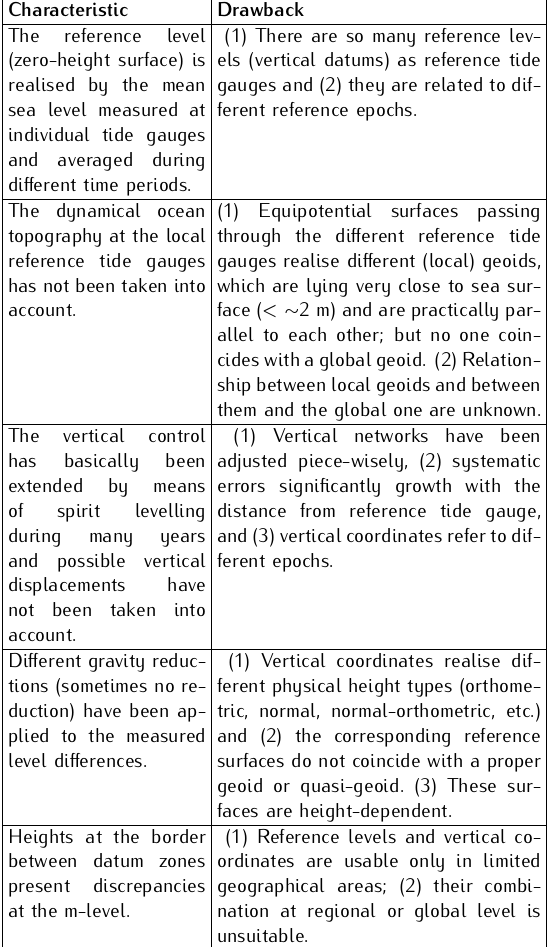
Table 1. Main characteristics and drawbacks of the existing height systems. Characteristic